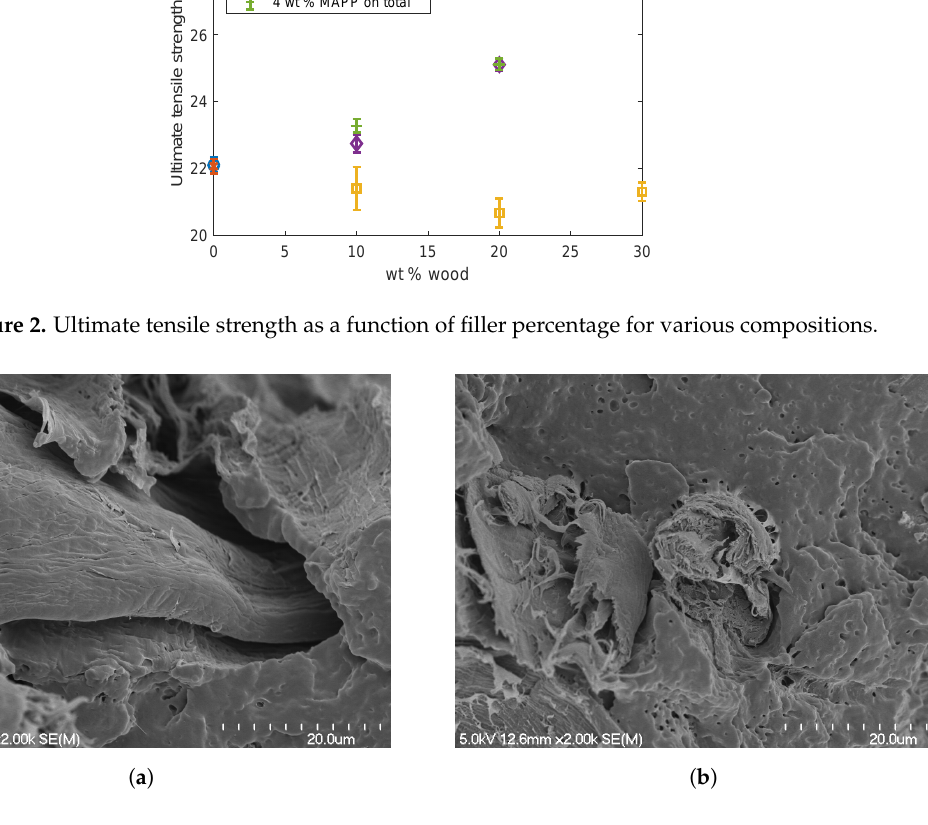
Figure 3. Scanning electron micrographs of the fracture surface of ( a ) a tensile specimen with 30 wt % CCA-treated wood fibres and ( b ) a tensile specimen with 30 wt % CCA filler and 3 wt %